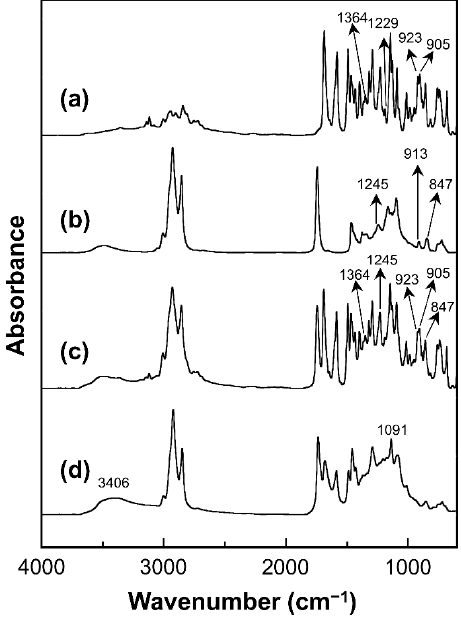
Figure 2. FT-IR spectra of ( a ) V-fa monomer, ( b ) epoxidized castor oil (ECO), ( c ) uncured V-fa/ECO binary mixture, and ( d ) fully cured V-fa/ECO copolymer.